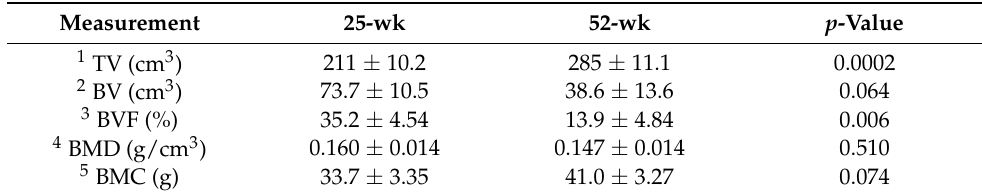
Table 3. Morphology, based on micro-computed tomography (micro-CT) scanning, of medullary bone from Hy-Line W36